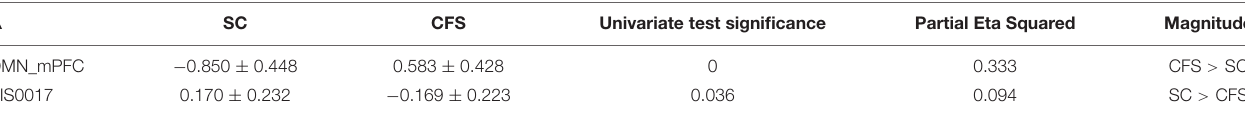
TABLE 5 | GLM for incremental